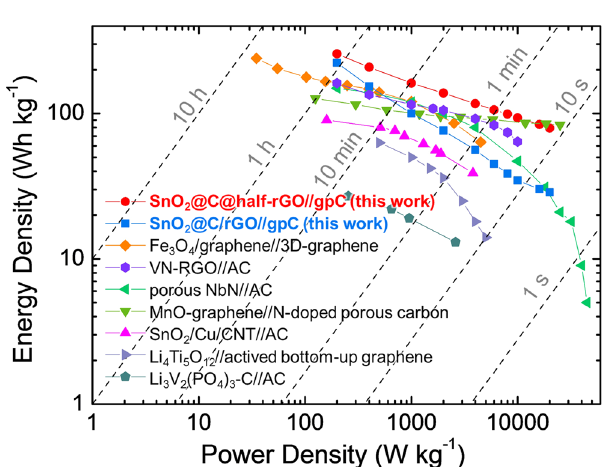
Figure 6. ( a ) The CV curves of SnO 2 @C@half-rGO//gpC LIHC in different voltage windows of 0–3.0 V, 0–3.5 V, 0–3.8 V and 0–4.0 V at 50 mV s − 1 . The CV curves of ( b ) SnO 2 @C@half-rGO//gpC and ( c ) SnO 2 @C/ rGO//gpC LIHC at different scan rates of 2, 5, 10, 20, 50 mV s − 1 in the voltage windows of 0–4.0 V. Galvanostatic charge-discharge curves of ( d ) SnO 2 @C@half-rGO//gpC and ( e ) SnO 2 @C/rGO//gpC LIHC at different current densities of 0.1, 0.2, 0.5, 1.0, 2.0, 5.0, and 10.0 A g − 1 . ( f ) Specific capacitance values of SnO 2 @C@half-rGO//gpC (red) and SnO 2 @C/rGO//gpC (blue) LIHC calculated from the result shown in ( d,e ).